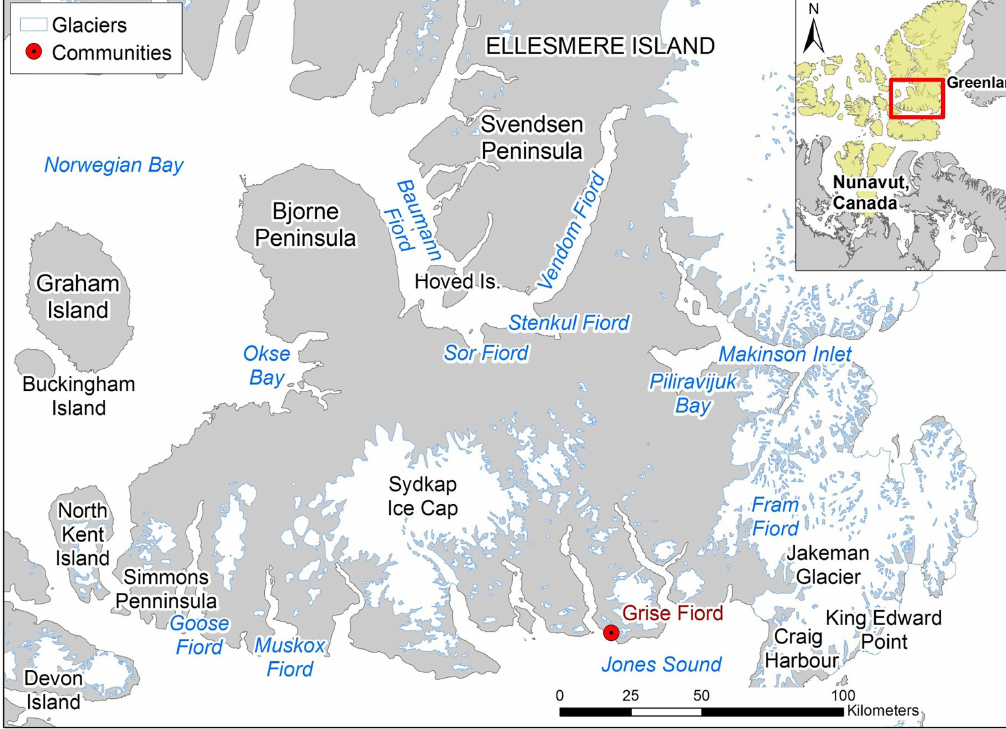
Figure 1. Study area on southern Ellesmere Island (approx.. 76°N to 78°N, 81°W to 90°W), Graham Island, and Buckingham Island, with major topographic features labelled. Peary caribou range is shown in yellow on the inset map for